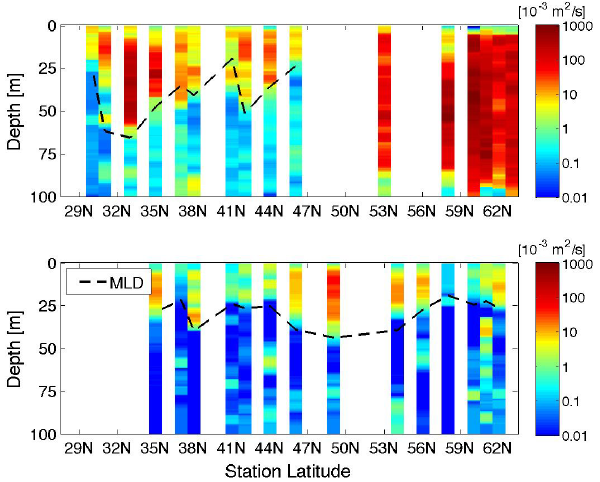
Figure 3. Phytoplankton cell concentration converted from the in- terpolated and smoothed Chl a concentrations measured during the spring (top) and summer (bottom) cruise. The dashed curve indi- cates the